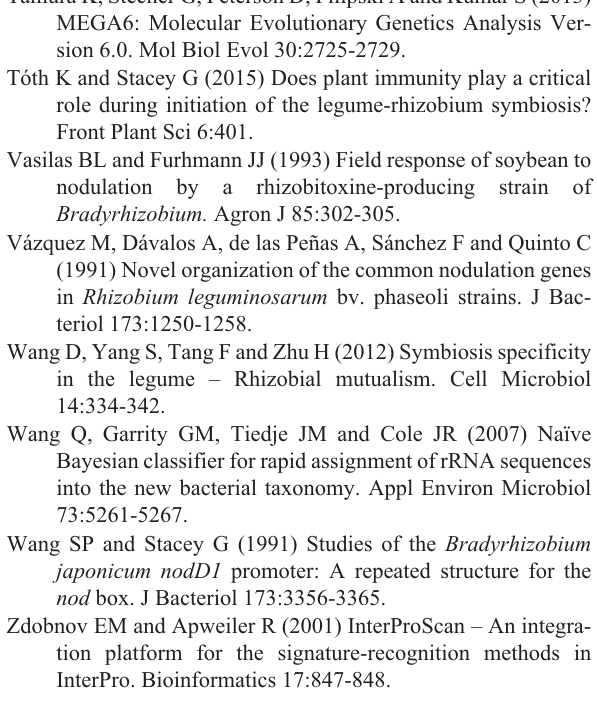
ventory. Figure S1 - Alignment of the ~250-bp region upstream from nolA and nodVW ORFs. Figure S2 - Evolutionary relationship of the nod regulatory proteins NodD and NodD 1 2. Figure S3 - Global similarity of NodD regulator proteins in B. elkanii strains. Figure S4 - Conservation plot from the multiple sequence alignment of NodD regulator proteins. Figure S5 - NodD global protein structure alignment for B. 1 elkanii strains against B. diazoefficiens USDA 110 using the Combinatorial Extension (CE) algorithm. Figure S6 - NodD global protein structure alignment for B. 2 elkanii strains against B. diazoefficiens USDA 110 using the Combinatorial Extension (CE) algorithm. Figure S7 - NodD -NodD global protein structure align- 1 2 ment within each Bradyrhizobium genome using the Com- binatorial Extension (CE)